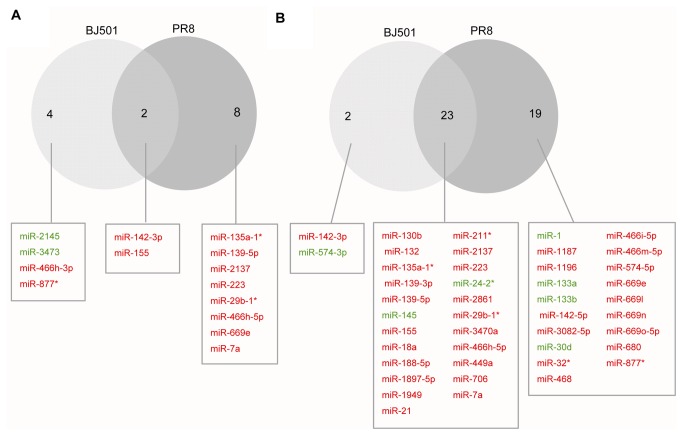
Comparison of differentially expressed microRNAs between the influenza virus BJ501 and PR8 infections.(A) Venn diagram of differentially expressed microRNAs during influenza virus BJ501 and PR8 infections relative to the mock-infected control on 2 dpi. (B) Venn diagram of differentially expressed microRNAs during influenza virus BJ501 and PR8 infections relative to the mock-infected control on 5 dpi. The diagram displays the names of differentially expressed microRNAs. The red color represents up-regulated microRNAs, while the green color indicates down-regulated microRNAs.